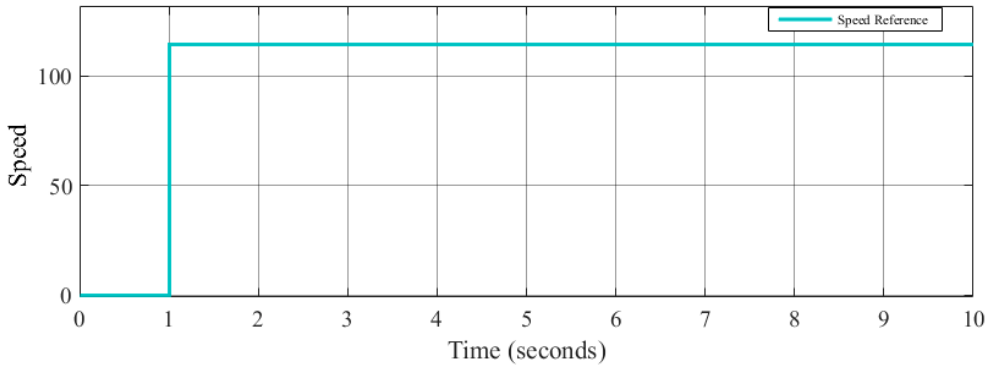
Figure 14. The step reference signal.